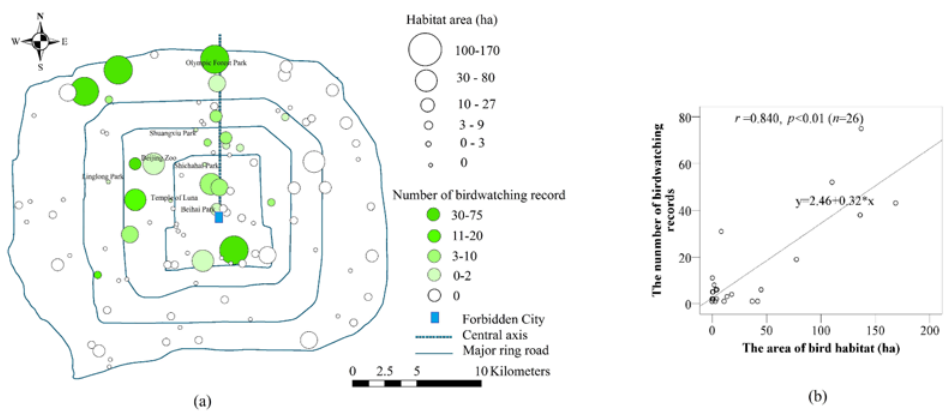
Figure 4. Bird habitat area and number of birdwatching records in parks of Beijing. ( a ) Spatial distributions of bird habitat area and number of birdwatching records; ( b ) the numeric relationship between bird habitat area and number of birdwatching records.